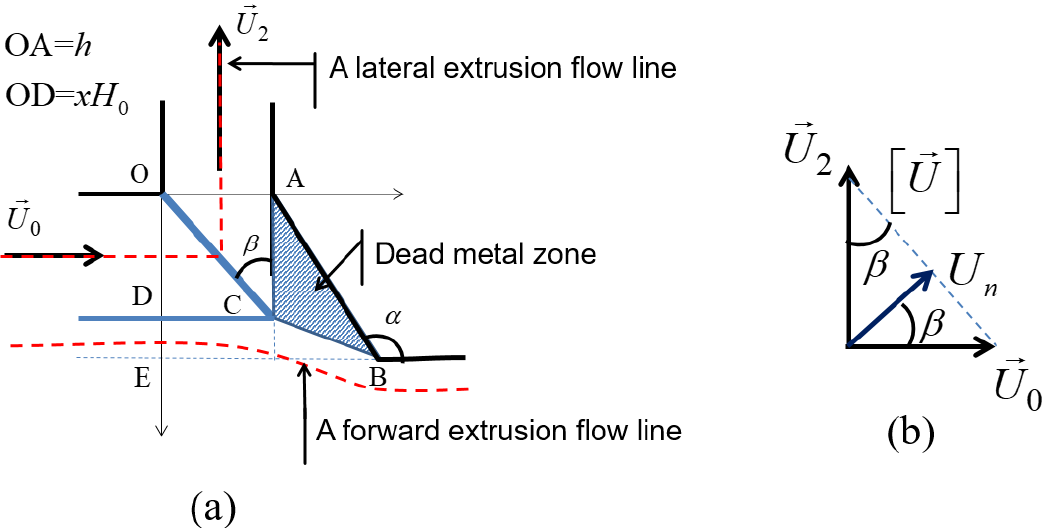
Figure 4. Schematic of a kinematically admissible velocity field for the flow into the lateral channel showing the dead metal zone ( a ); the velocity hodograph is shown in ( b ).